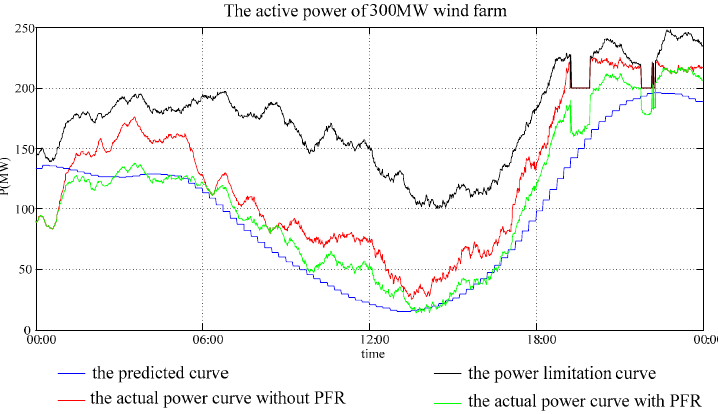
Figure 16. The predicted power, the power limitation, the actual power without PFR and the actual power with PFR of the 300 MW wind farm.